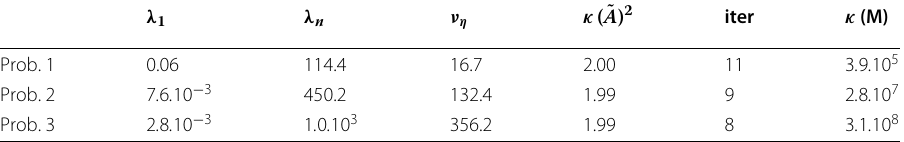
Table 3 Optimal parameter ν η of Theorem 1, with η = 1 and condition numbers of matrices for the cylinder problems